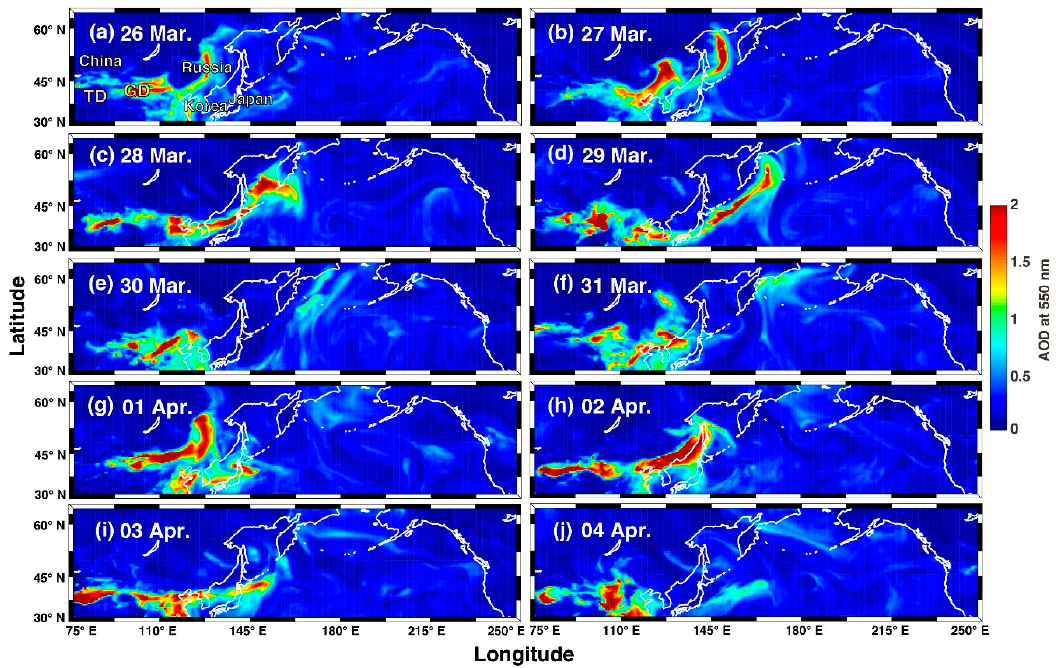
Figure 2. ( a ‒ j ) Spatial distributions of total AOD at 550 nm data from CAMS at 12:00 UTC from